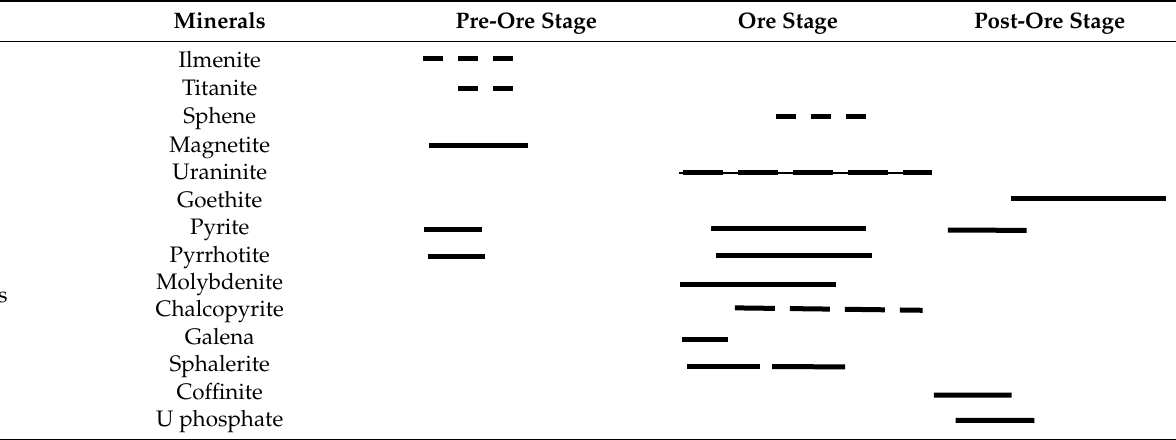
Table 6. A paragenetic sequence of ore minerals inferred from their textural relationships.